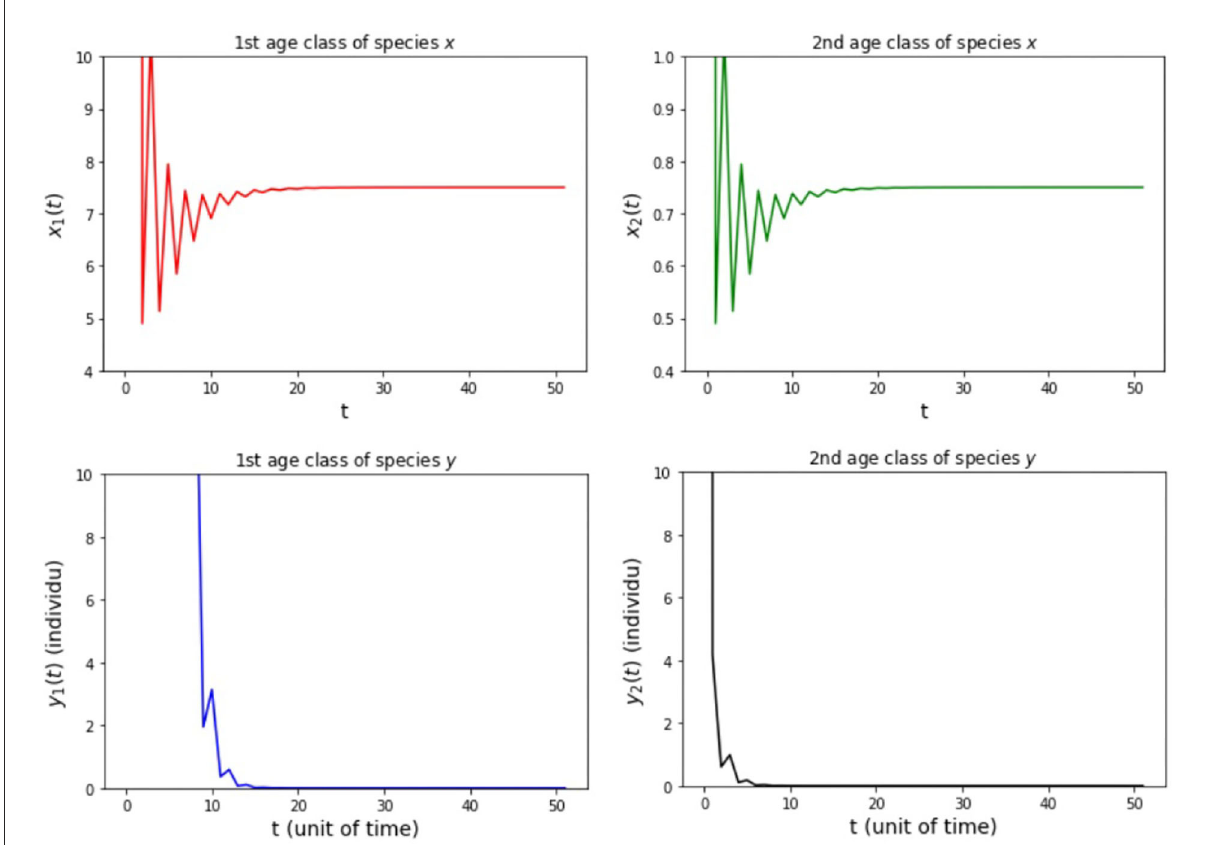
FIGURE6 Population growth of each age class from case (ii) Model